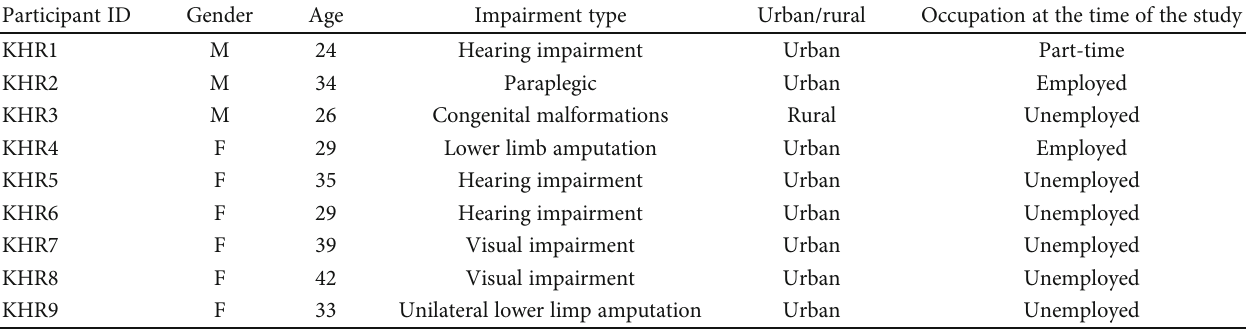
Table 2: Summarised description of participants with disabilities from the peri-urban Khomas region that engaged in a focus group discussion ( n = 9 ).